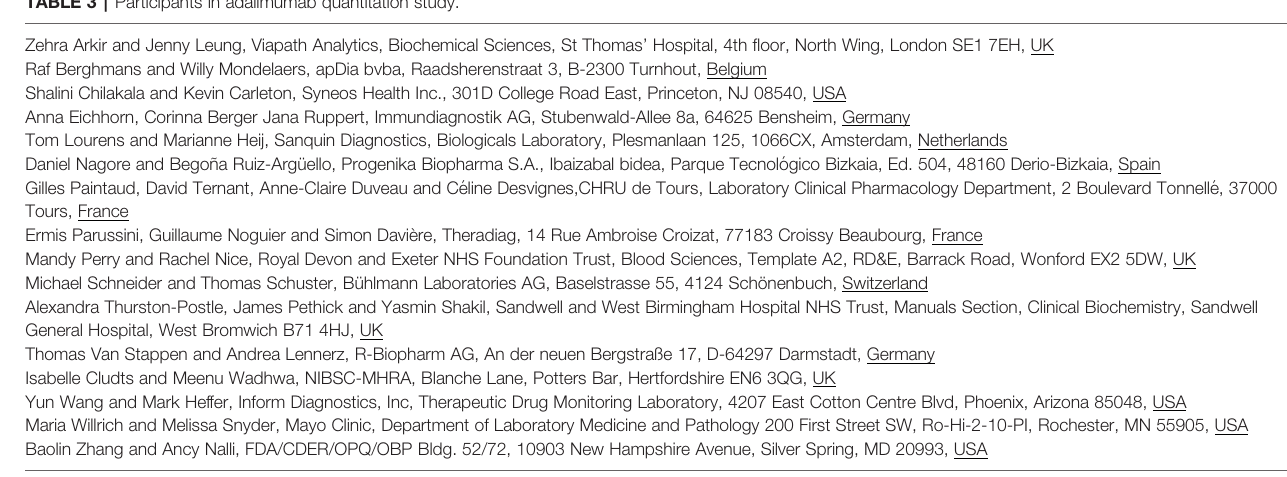
TABLE 3 | Participants in adalimumab quantitation